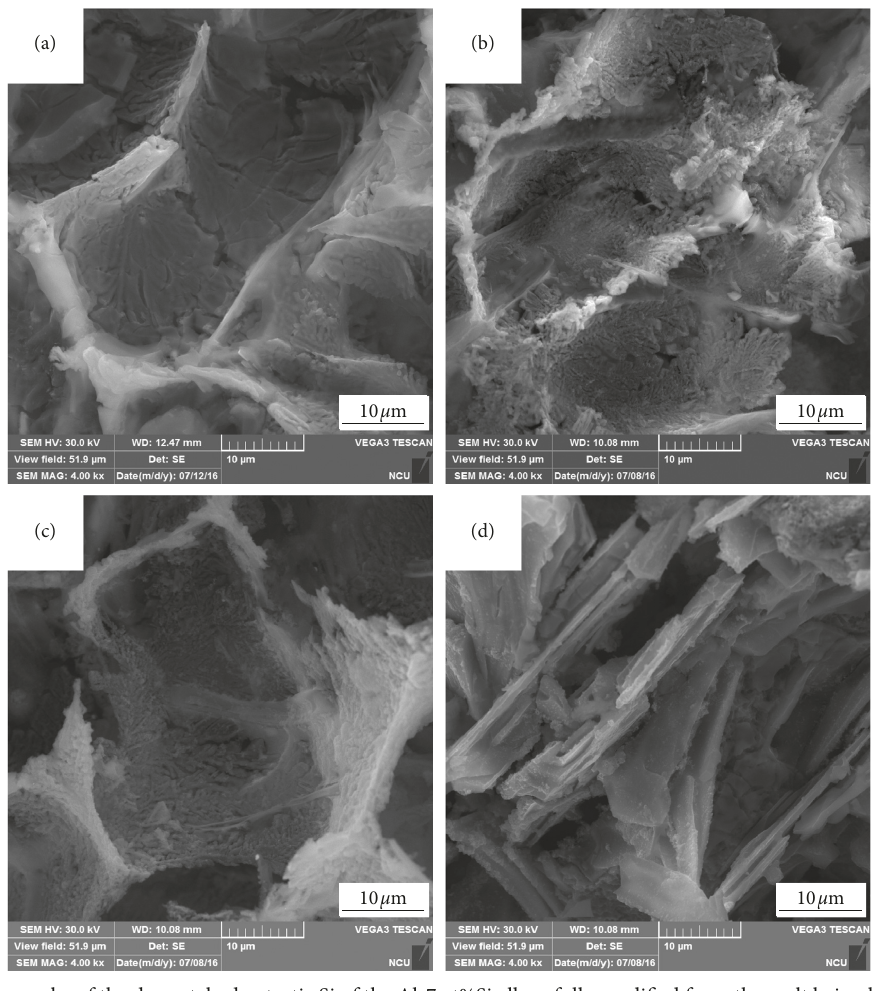
Figure 6: SEM micrographs of the deep etched eutectic Si of the Al-7wt%Si alloys fully modified from the melt being held for (a) 5min, (b) 15min, (c) 60min, and (d) 120 min after combined additions of 0.05 wt.% Sr and 0.7 wt.% Yb.